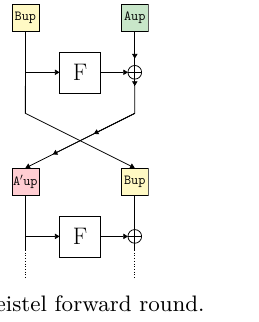
Figure 4: Encryption (4a) and decryption (4b) procedure of a classical Feistel cipher. Note that the F function is never inverted and that the only difference comes from the direction in which the XOR is